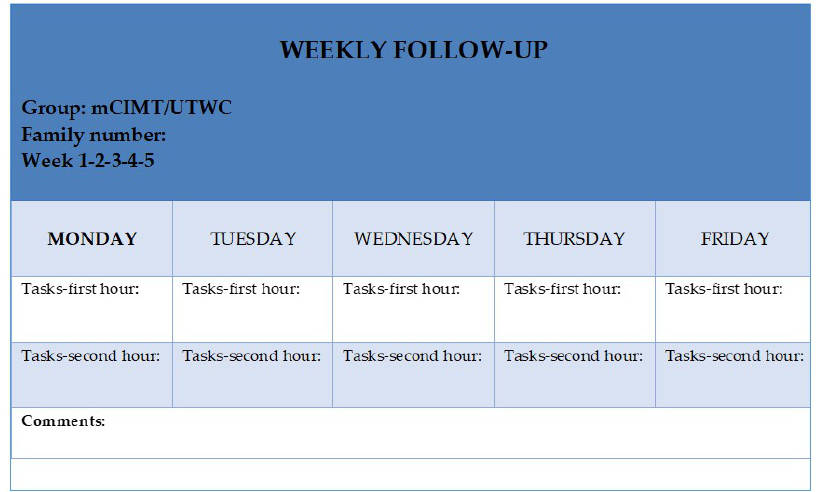
Figure 1. Weekly follow-up for families.